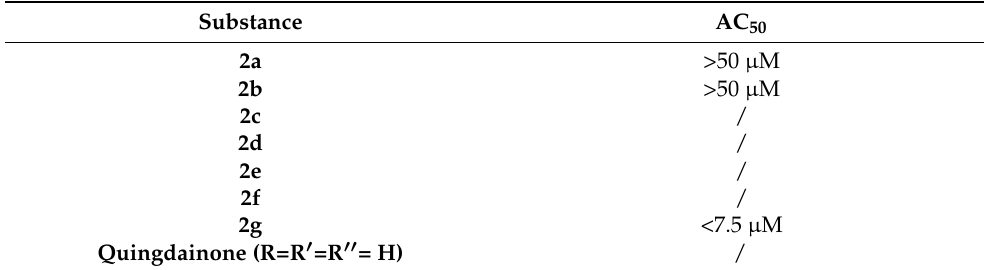
Table 2. AC 50 values of the synthesised quingdainone variants. They describe the concentration of compounds able to induce apoptosis in 50 percent of the Nalm-6 cells after 72 h of incubation. Com- pounds with no significant apoptosis induction up to 50 µM are marked with a slash. Quingdainone is not active at all in our cell lines.